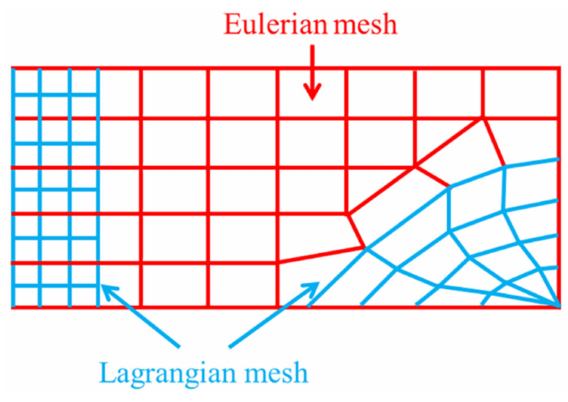
Figure 3. Schematic of the ALE coupling